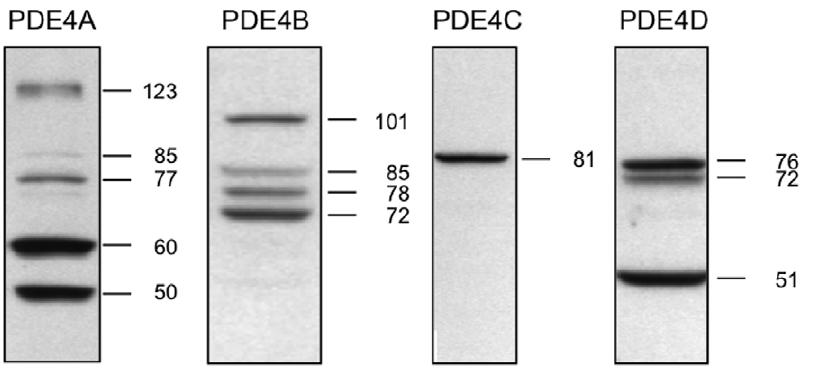
Figure 3. Protein expression pattern of PDE4 in the kidneys of 8 week-old CBA/J control mice. PDE4A, PDE4B, PDE4C, and PDE4D protein expression was assessed on 8 week-old CBA/J control mice as described in the Methods section. The apparent size of protein bands is expressed in kDa.